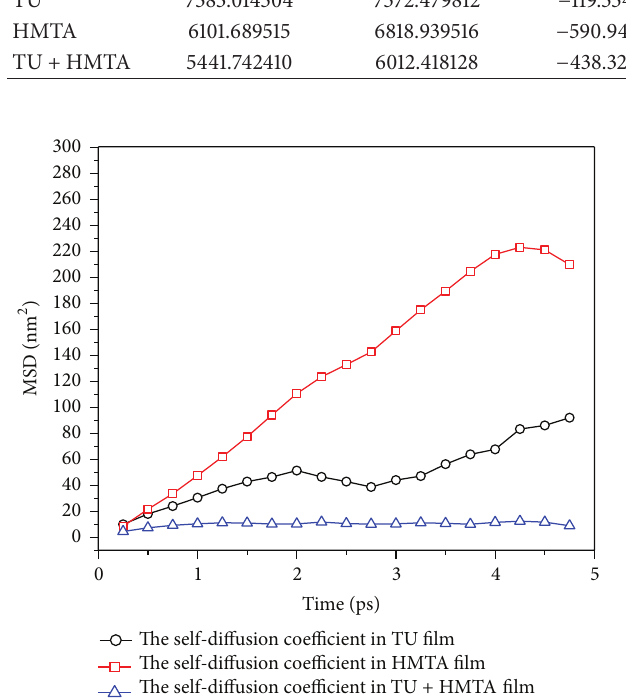
Table 5: Interaction and binding energy of the benzotriazole derivatives on N80 (1 1 1) surface at 25 ± 1 ∘ C. Inhibitors